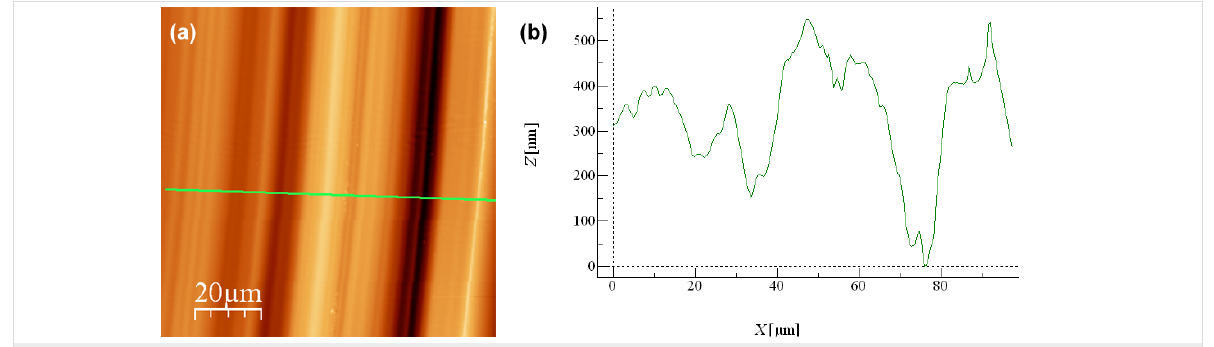
Figure 2: (a) AFM observation of the worn surface of Si submitted to nanotribological tests under dry conditions and (b) height profile of the worn region.